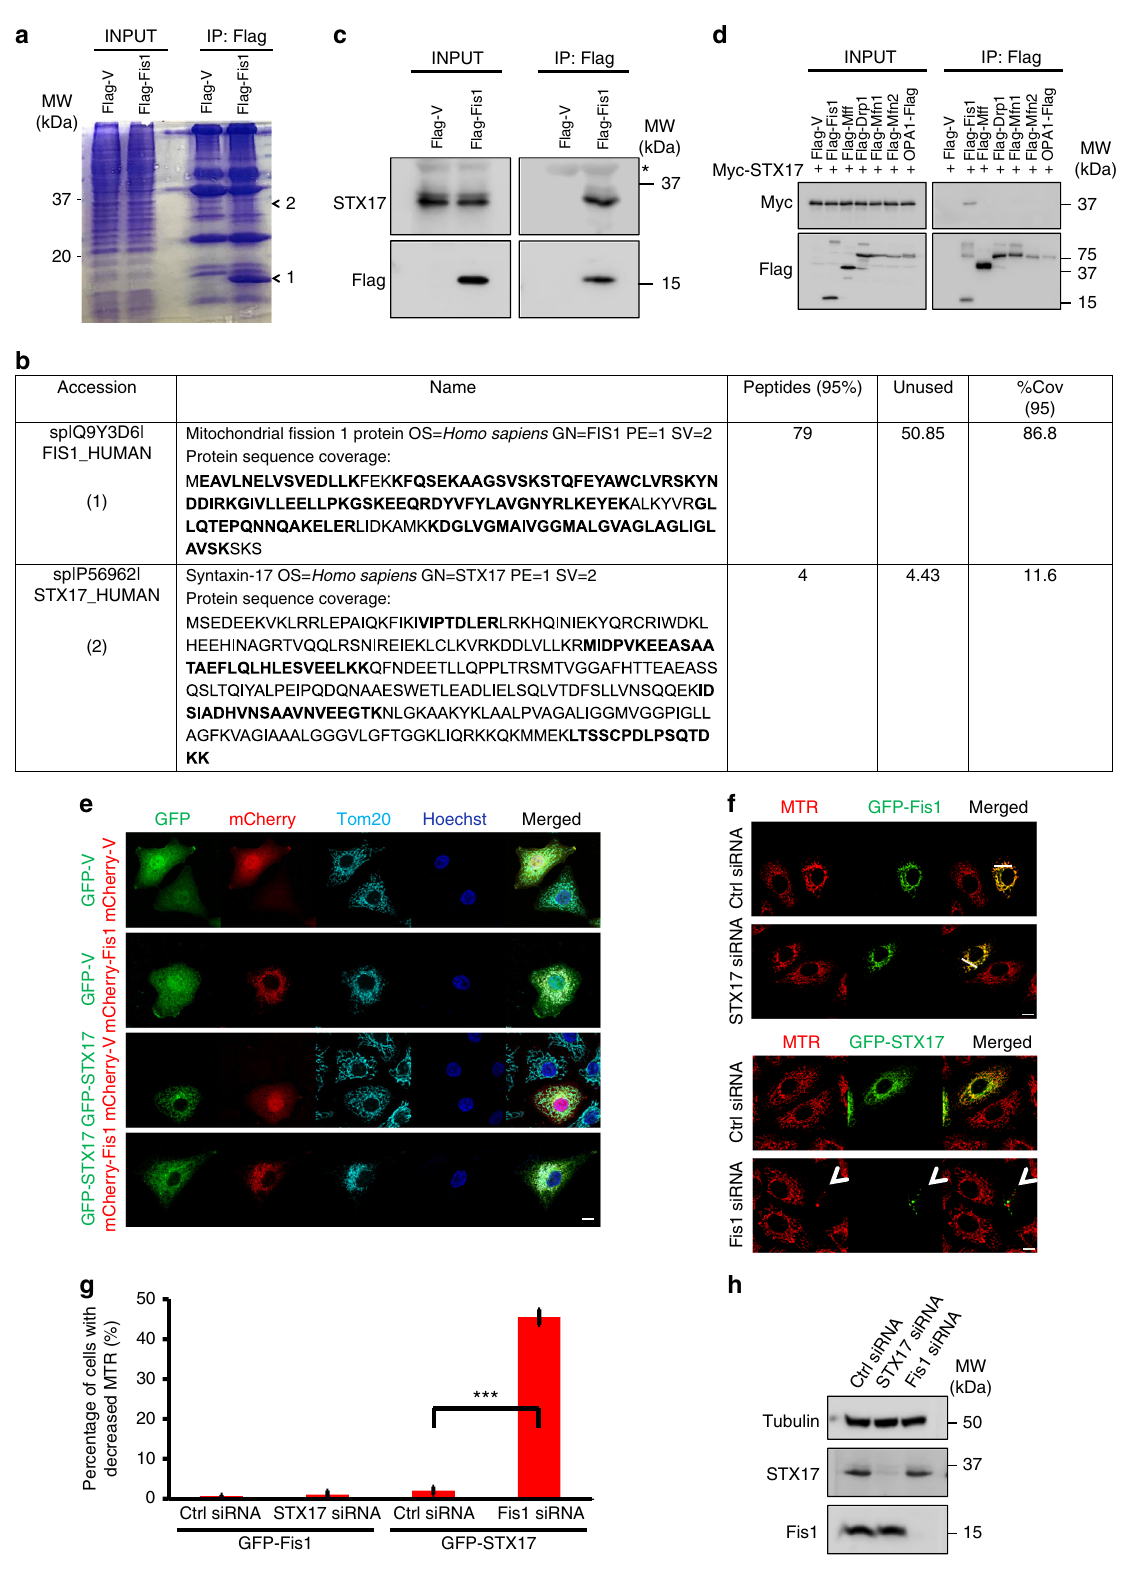
KO cells, fragmented mitochondria were enclosed within autop- mitochondria (MTR or Tom20) (Supplementary Fig. 1g). Fur- hagosome (LC3), autophagy receptor (P62), and lysosome thermore, STX17 induced a signi fi cant decrease of overall mito- (Lamp2), observed by three-dimensional reconstructed images chondrial proteins in Fis1 KO cells detected by immunoblotting, (Fig. 2c, d, Supplementary Fig. 2e, f, and Supplementary Movie 1). and lysosomal inhibitor chloroquine (CQ) substantially rescued the turnover of mitochondrial proteins, suggesting that the Meanwhile, STX17 was found to occasionally colocalized with the NATURE COMMUNICATIONS|